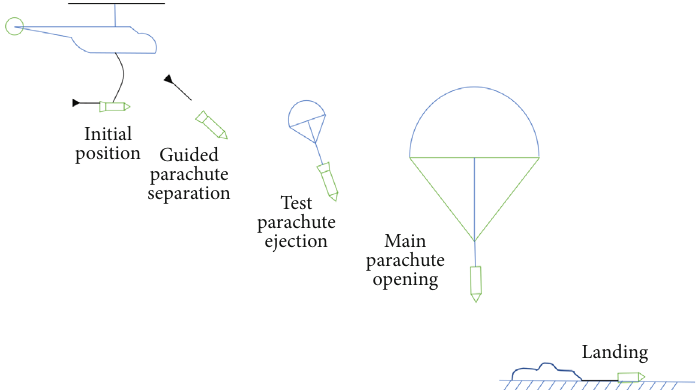
Figure 2: Airdrop